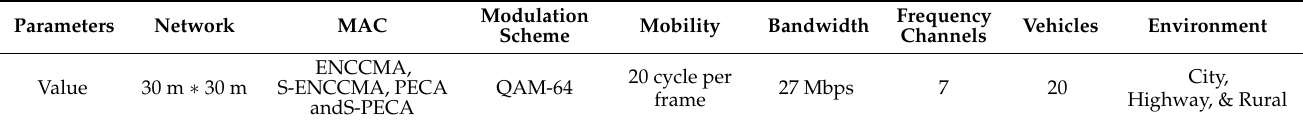
Table 4. Simulation parameters